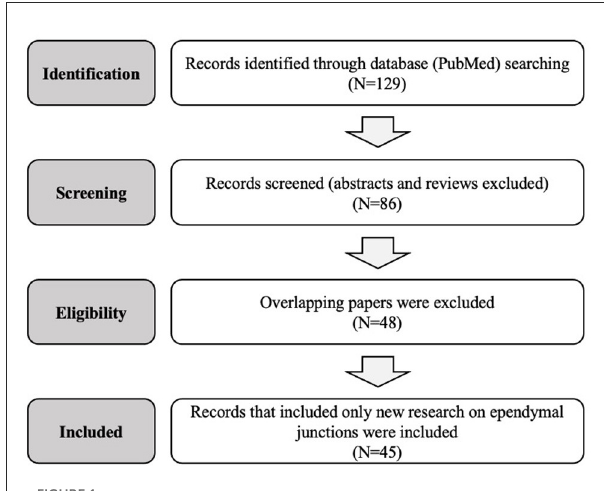
FIGURE1 Flow diagram of the systematic research and selection process used to identify the final papers in this